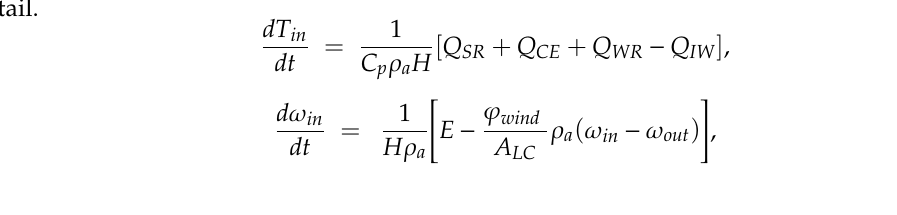
Table A2. Units of the